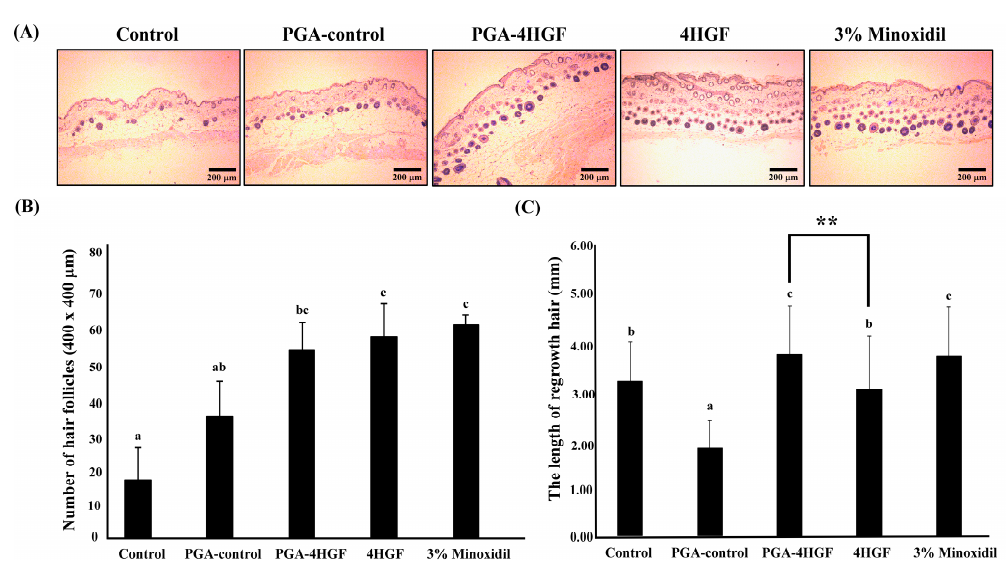
Figure 4. The effect of PGA-4HGF on hair follicles and hair length in telogenic C57BL/6N mice. ( A ) Transverse sections of the dorsal skins (12 days) stained with hematoxylin and eosin (H&E). Representative photomicrograph of the hair follicles in dorsal tissue treated with distilled water (DW), PGA, PGA-4HGF, 4HGF, or 3% minoxidil (200× magnification, scale bars: 200 μ m). ( B ) The number of hair follicles of dorsal skins (400 × 400 μ m 2 ) and ( C ) the length of hair at 12 days after treatment with DW, PGA-control, PGA-4HGF, 4HGF, or 3% minoxidil. Data represent means ± deviation (SD) ( n > 30 hairs). Data were analyzed with one-way ANOVA/Duncan’s t -test ( p < 0.05). Values with a, b, c in the same row are significantly different. Data was analyzed with independent t -test (** p < 0.01).